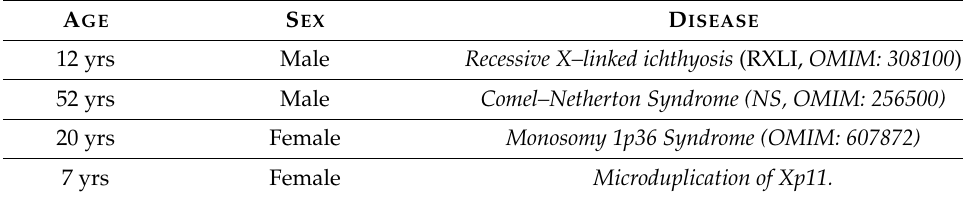
Table 1. Patients with inborn error and impaired IgE production under